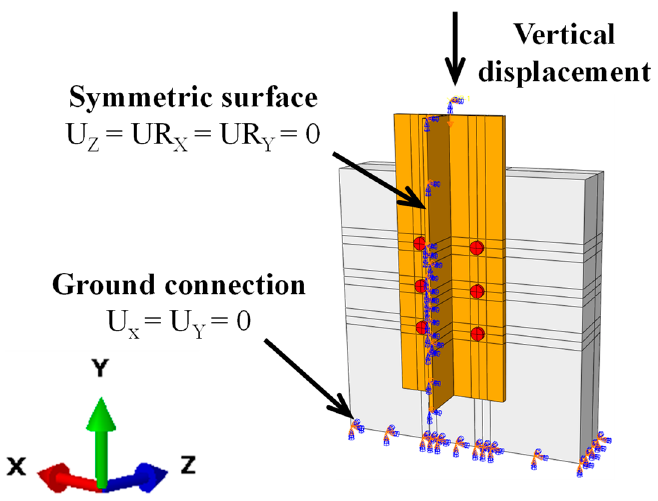
Figure 5. Boundary conditions.